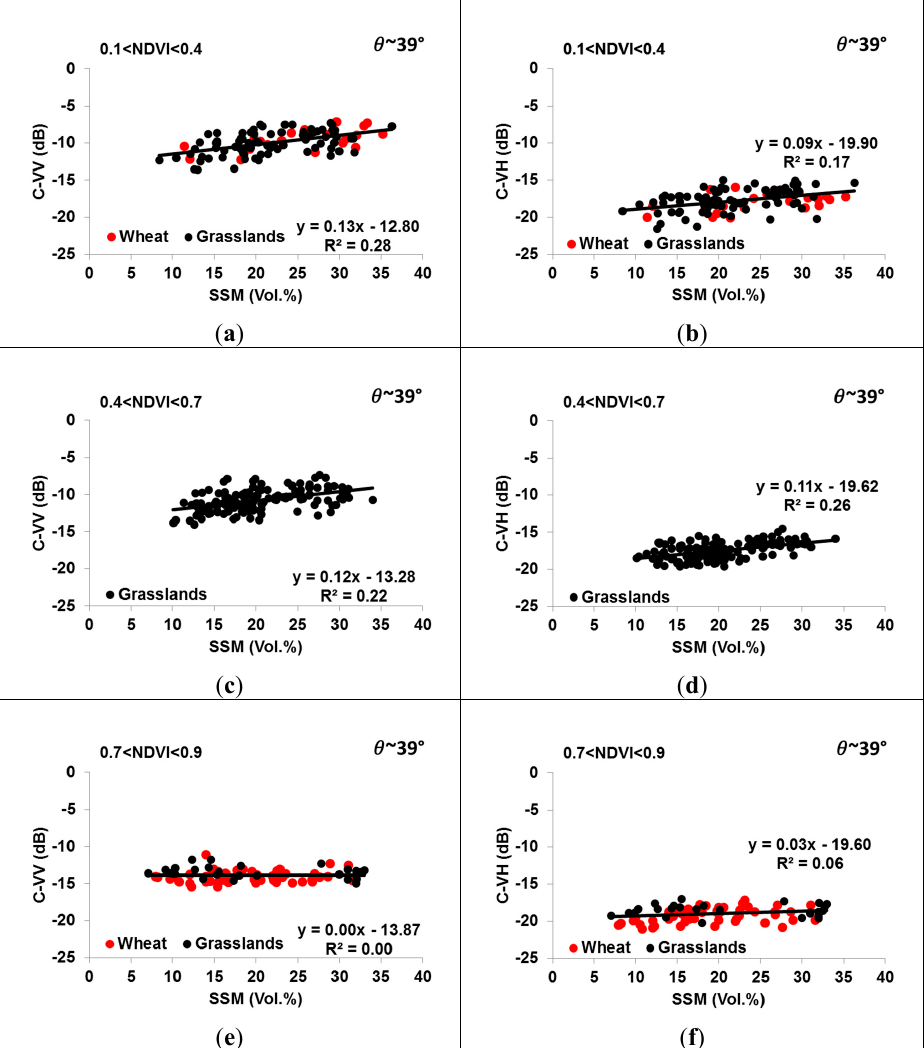
Figure 3. Sensitivity of C-band backscattering coefficient as a function of SSM for three ranges of NDVI values. ( a ): C-VV and 0.1 < NDVI < 0.4; ( b ): C-HV and 0 < NDVI < 0.4; ( c ): C-VV and 0.4 < NDVI < 0.7; ( d ): C-HV and 0.4 < NDVI < 0.7; ( e ): C-VV and 0.7< NDVI < 0.9; ( f ): C-HV and 0.7 < NDVI <